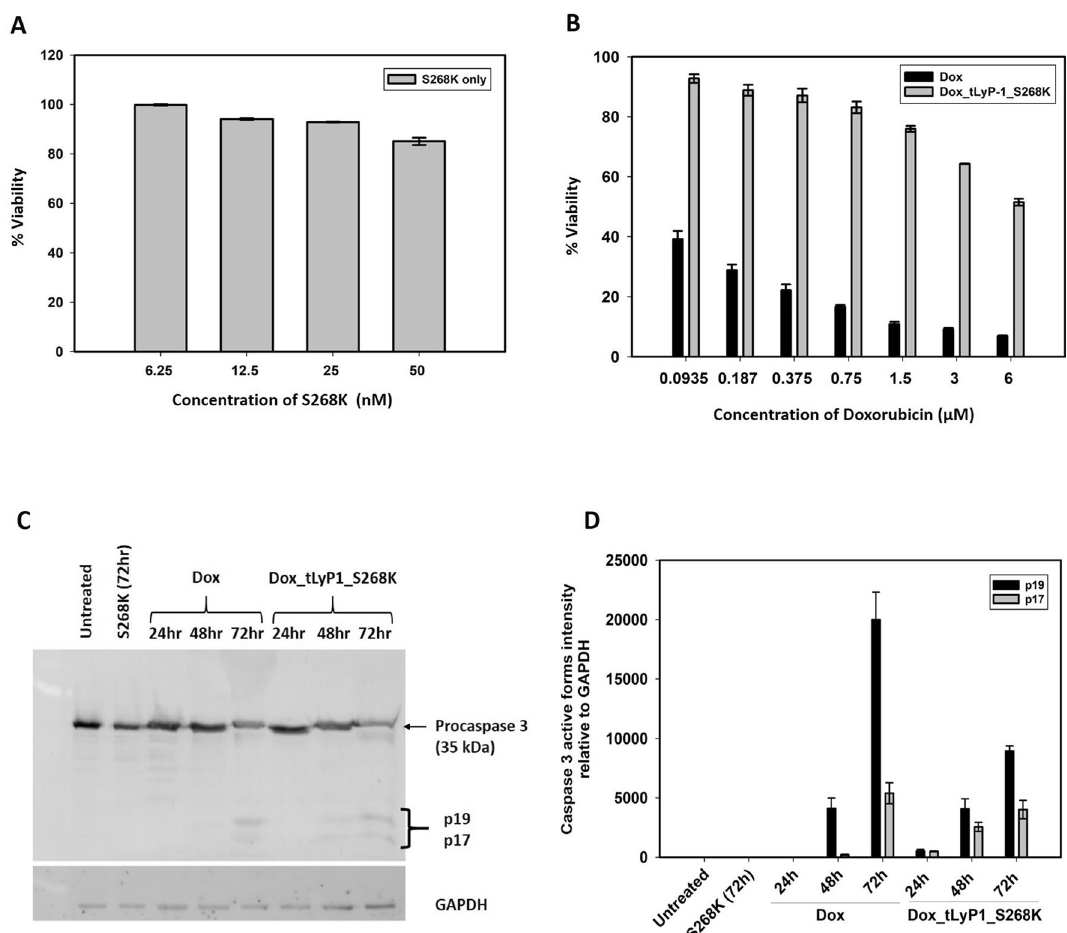
Figure 5. Encapsulated doxorubicin induces apoptosis mediated cell cytotoxicity in MDA-MB-231 cells. Evaluation of cytotoxic effect of ( A ) S268K FHV VLPs and ( B ) free doxorubicin and Dox_tLyp-1_S268K VLPs post 72 h of treatment by MTT assay; ( C ) Immunoblotting showing cleavage of caspase 3 into its active subunits (p17 and p19), and ( D ) the corresponding densitometric analysis. Note: for ( C , D ), n = 2 where ‘n’ represents different experimental